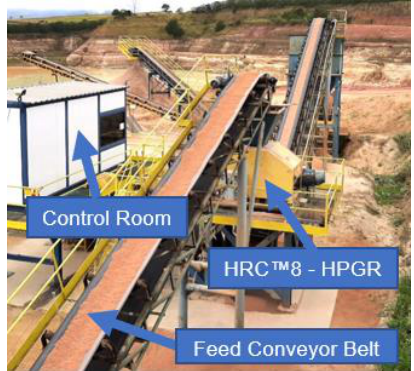
Figure 3. Itaquareia HRC ™ industrial plant.